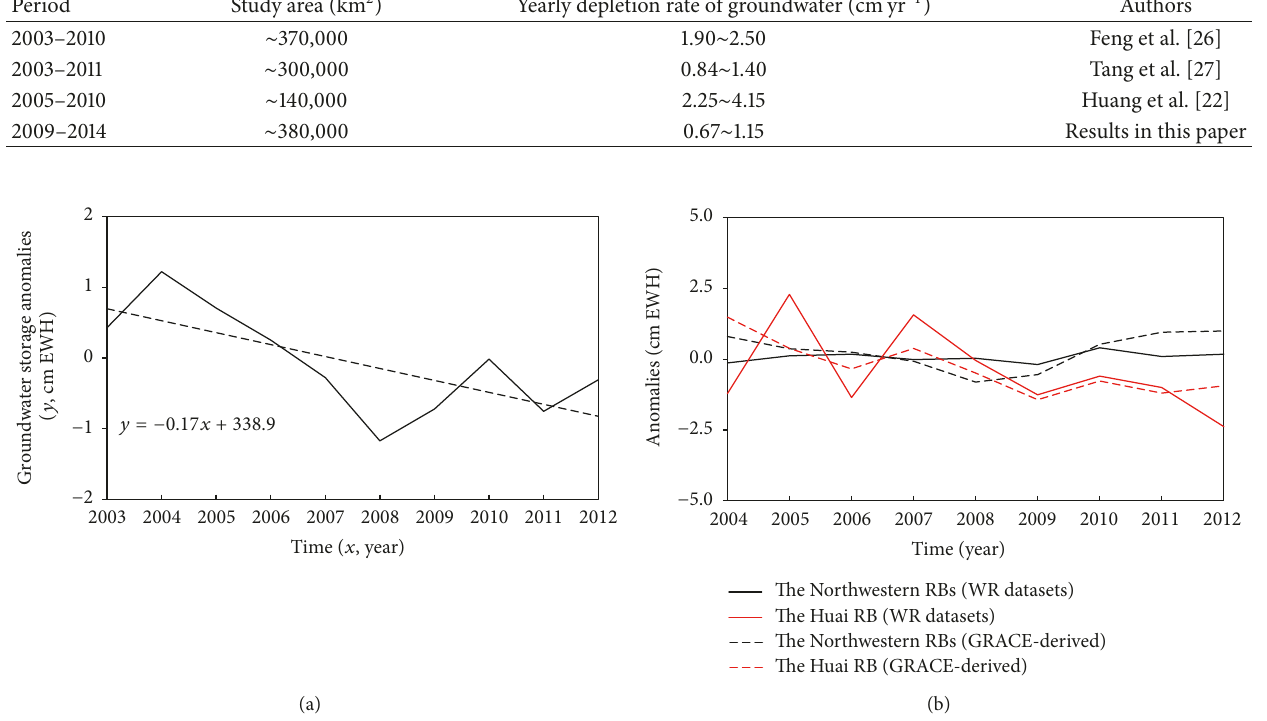
Figure 8: Variations of groundwater storage in Northern China and three river basins.